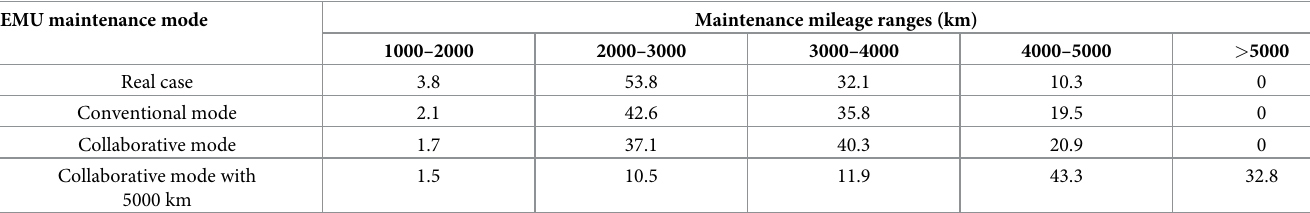
Table 13. Distribution of maintenance tasks performed in different mileage ranges